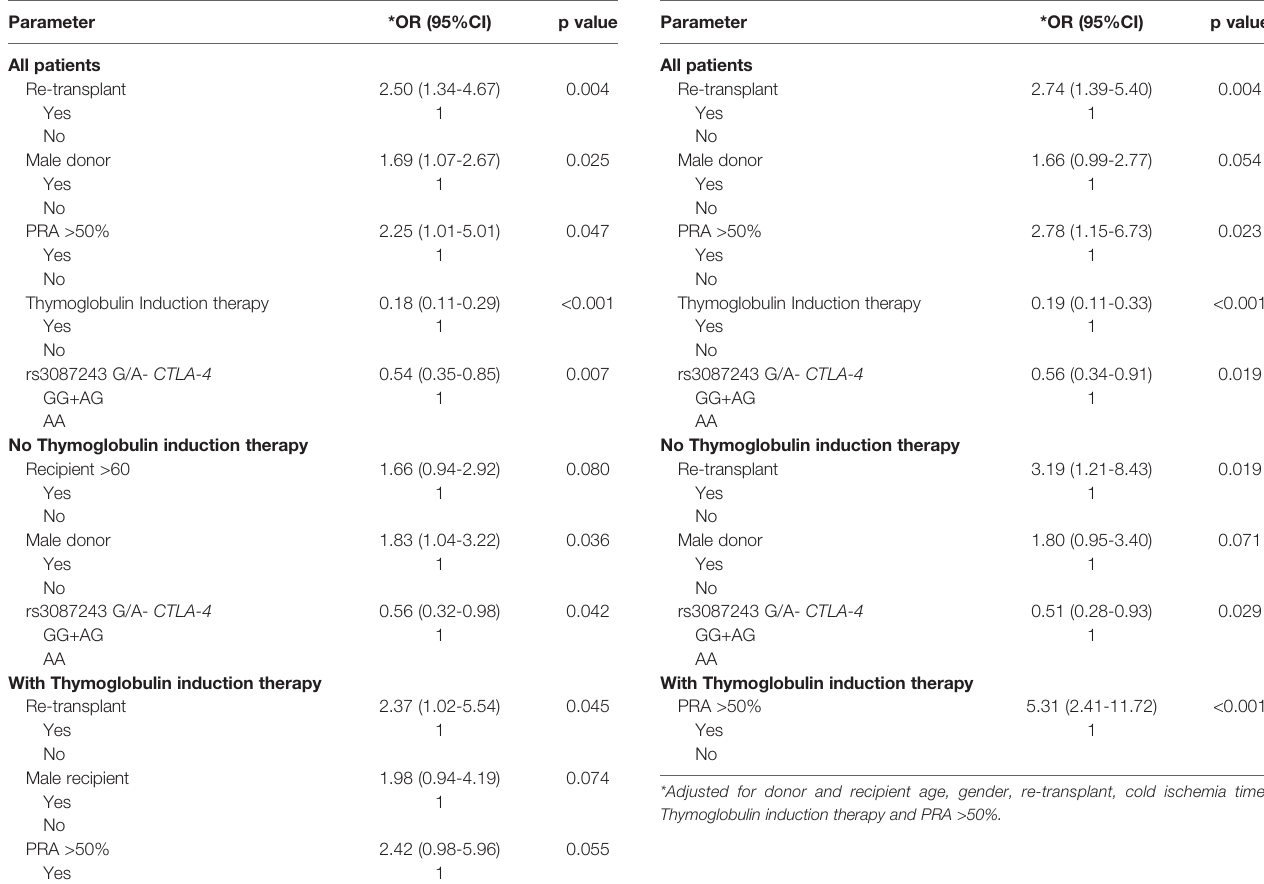
TABLE 4 | Multivariate analysis for TCMR. TABLE 5 | Multivariate analysis for TCMR Banff ≥